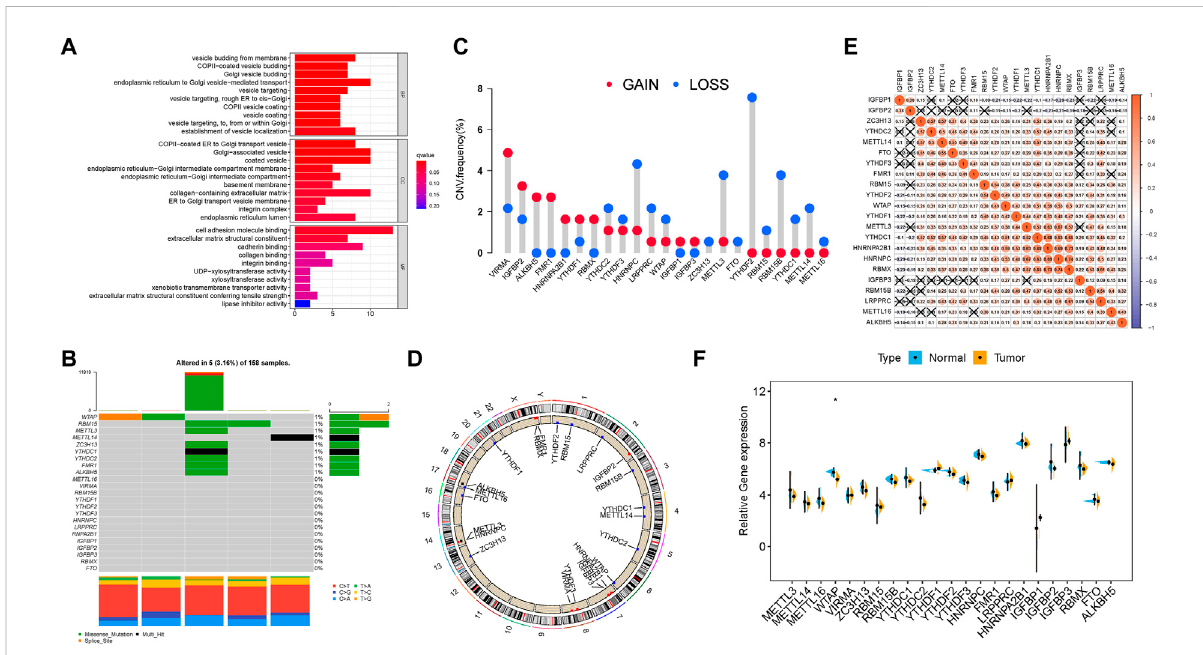
FIGURE 1 Landscapeofgeneticalterationsofm6AregulatorsinPDAC. (A) GOenrichmentanalysisofthe23m6Aregulators.The x -axisindicatesthegene ratio within each GO term. (B) Five of the 158 HCC patients experienced genetic alterations of 23 m6A regulators, with a frequency of 3.16%, mostly including ampli fi cation, missense mutations, and deep deletions. The number on the right indicates the mutation frequency in each regulator. Each columnrepresentsanindividualpatient. (C) CNVmutationfrequencyof23m6Aregulatorswasprevalent.Thecolumnrepresentsthealteration frequency. The deletion frequency is represented by the green dot; the ampli fi cation frequency is represented by the red dot. (D) Location of CNV alteration of m6A regulators on chromosomes. (E) Broad co-expression correlation among the 23 m6A RNA modi fi cation regulators in PDAC. “ X